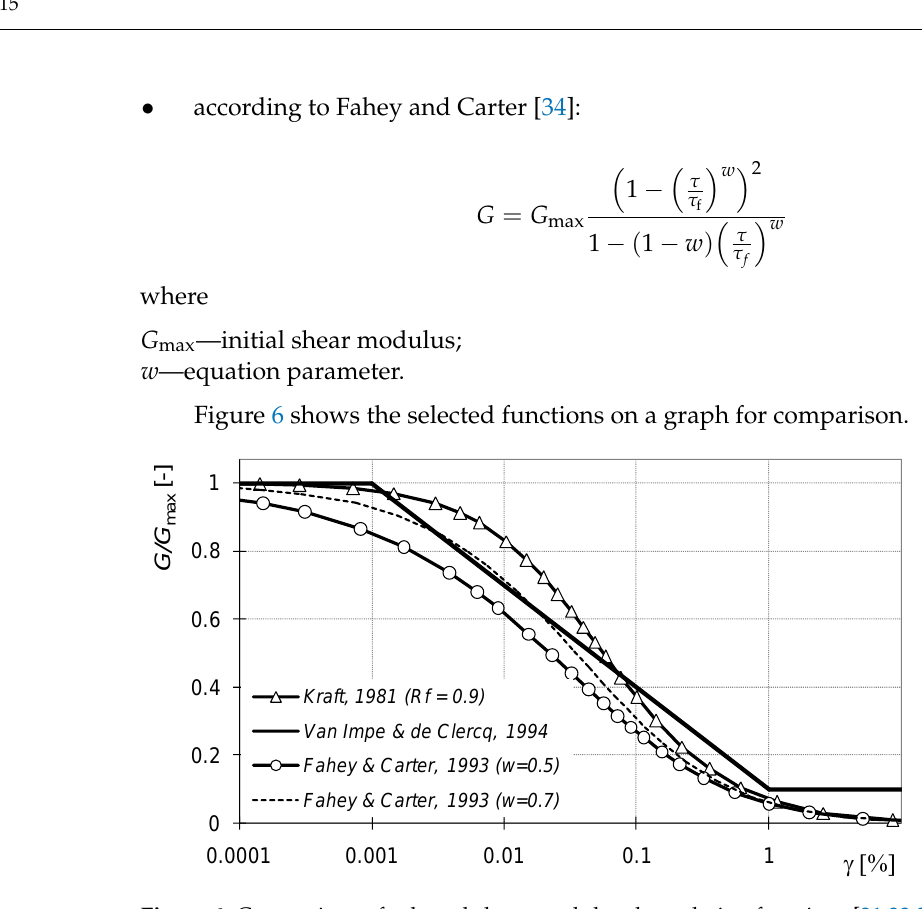
Figure 6. Comparison of selected shear modulus degradation functions [21,33,34].